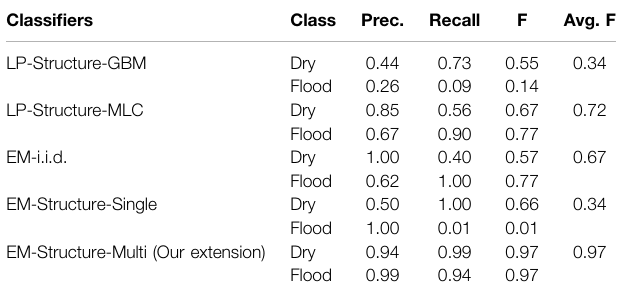
TABLE 6 | Comparison on Mathew, Kinston fl ood data. Classi fi ers Class Prec.